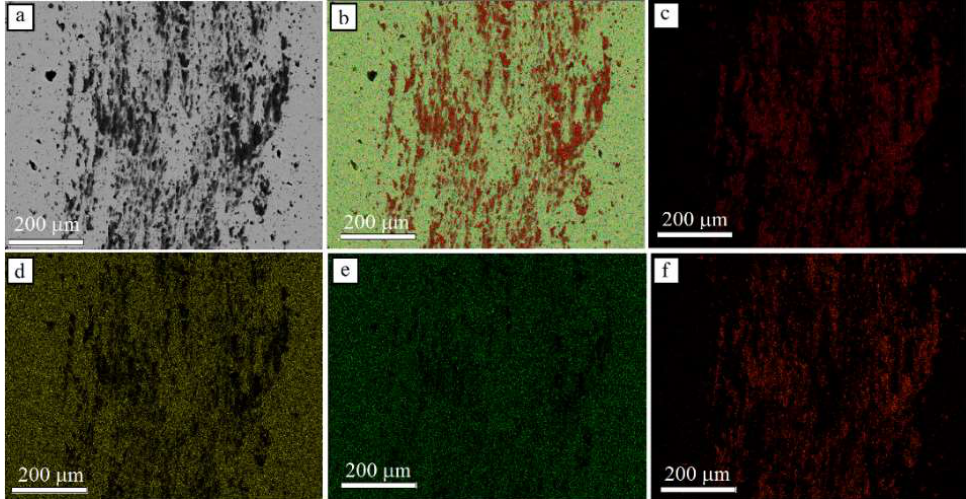
Figure 13. SEM image ( a ) and EDS element distribution maps for all elements ( b ), O ( c ), W ( d ), Zr ( e ), and Fe ( f ) obtained from the worn surface of the ZrCrN(5) coating after sliding at 1N.